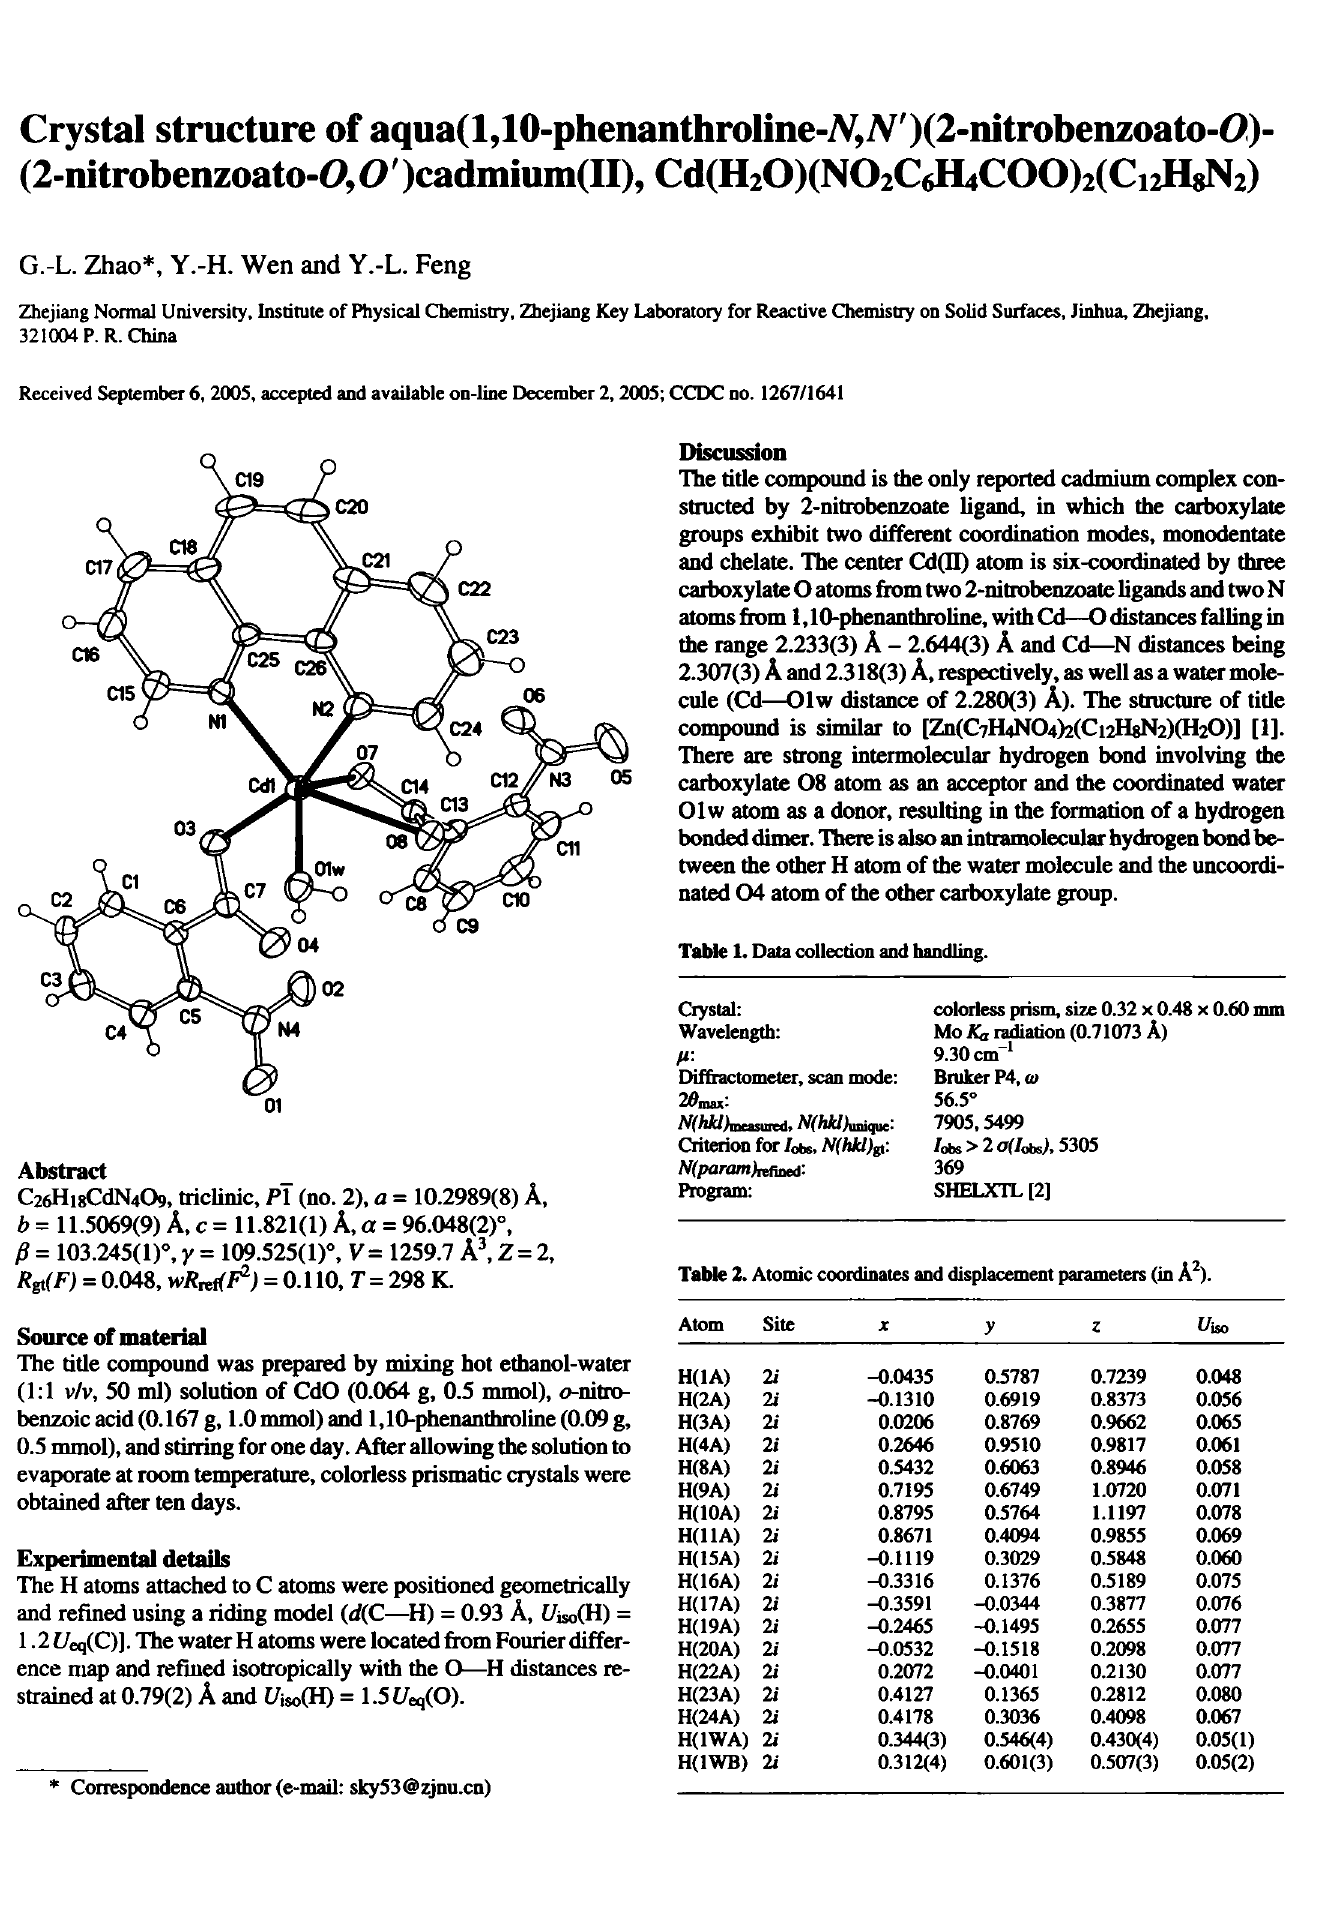
Table 2. Atomic coordinates and displacement parameters (in A 2